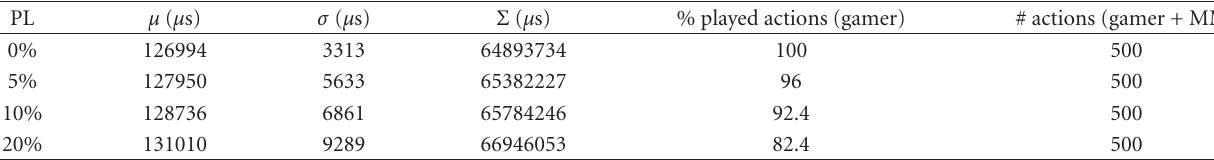
Table 1: Performance evaluation of PS with di ff erent packet losses.